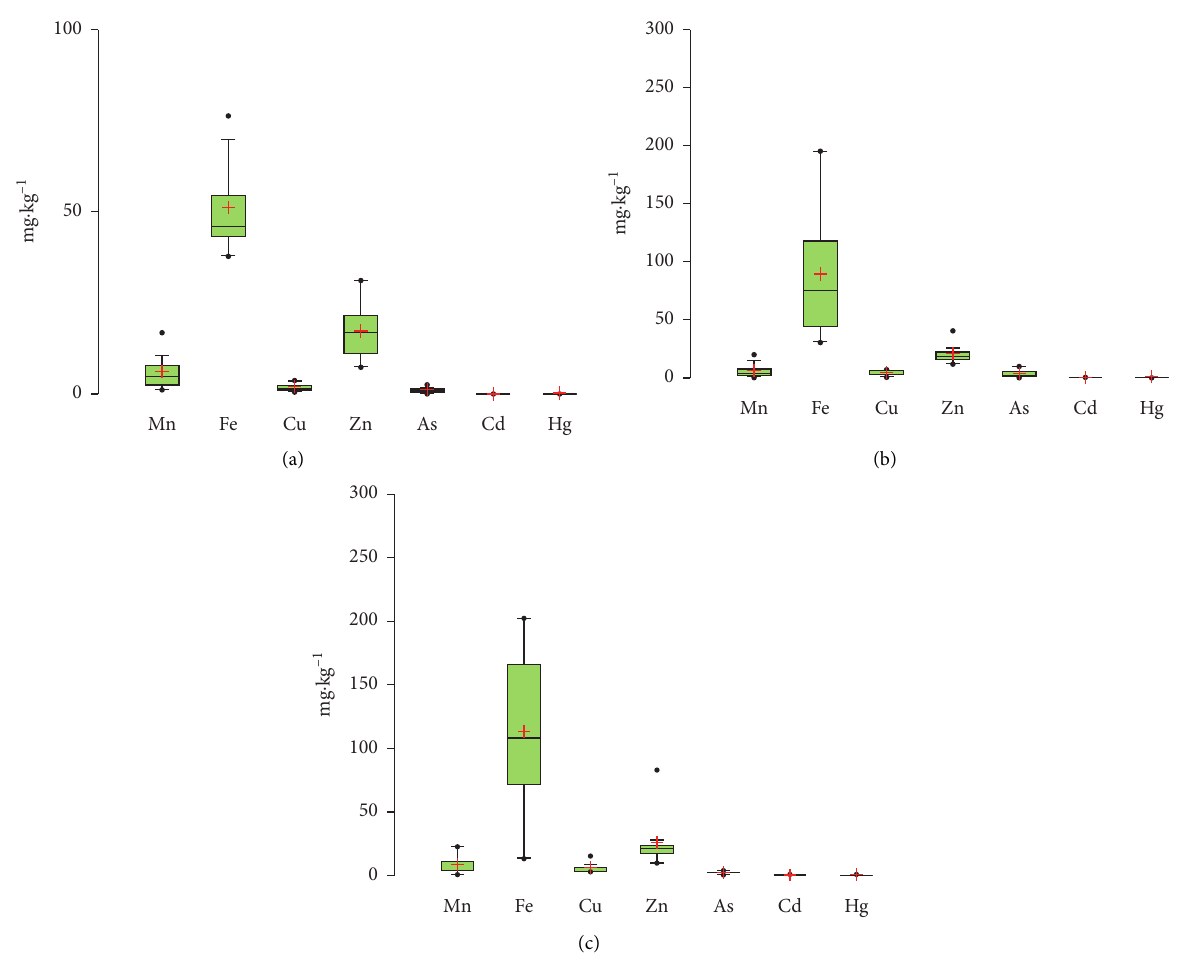
Figure 2: Trace metal element contents in (a) Fishes, (b) Crustaceans, and (c) Moluscs in the Red River coastal